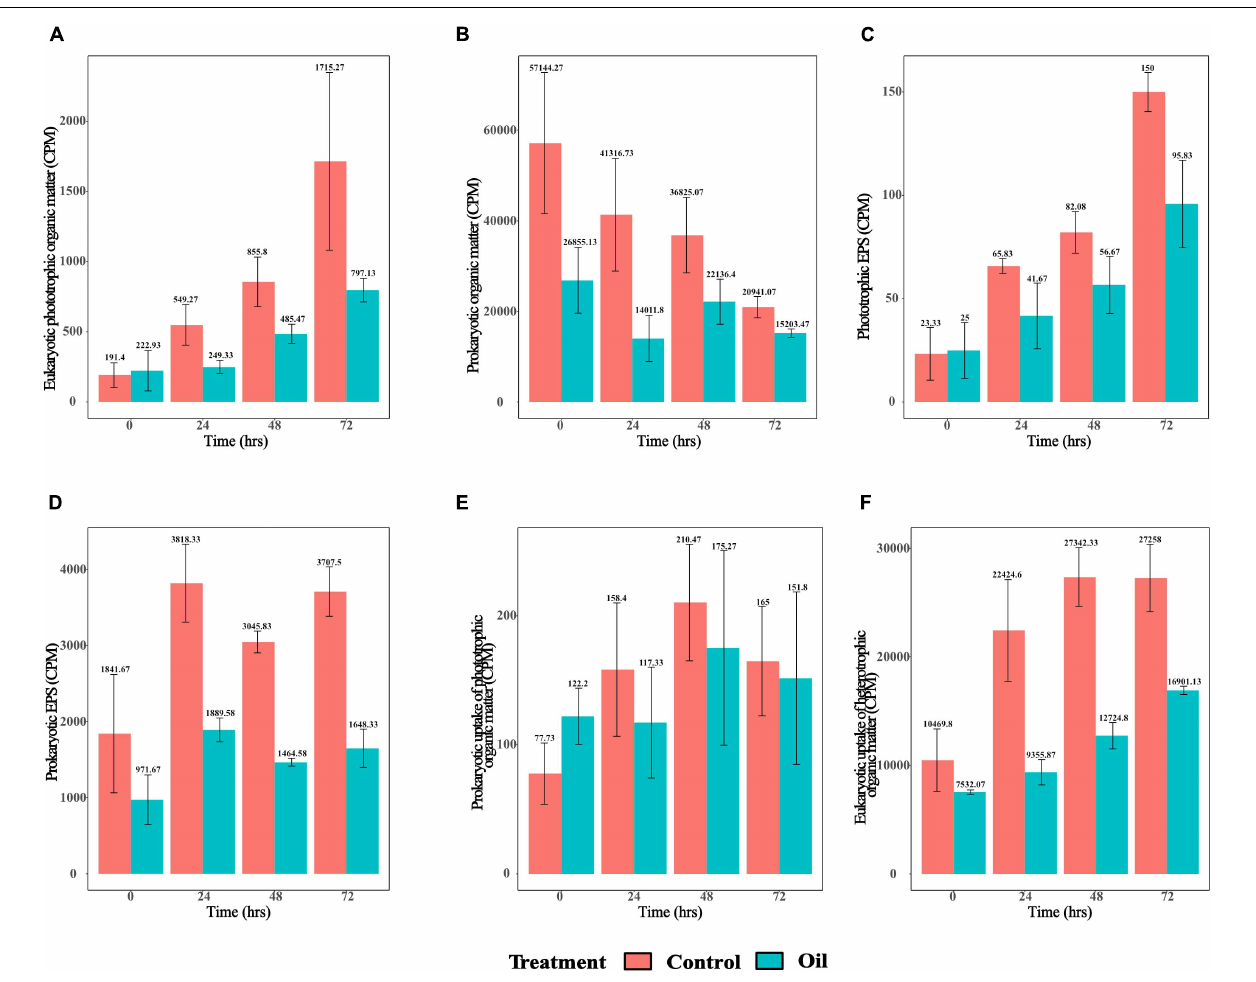
FIGURE 1 | Radiotracer signals from the long-term experiment. (A) Eukaryotic phototrophic organic matter as indicated by the 14 C signatures in ≥ 3- µ m fraction (CPM), (B) prokaryotic organic matter as indicated by 3 H signatures in ≥ 0.2- µ m fraction (CPM), (C) phototrophic exopolymeric substance (EPS) as indicated by 14 C signatures in ≥ 3-kDa fraction (CPM), (D) heterotrophic EPS indicated by 3 H signatures in ≥ 3-kDa fraction (CPM), (E) prokaryotic uptake of phototrophic organic matter as indicated by 14 C signatures in ≥ 0.2- µ m fraction (CPM), and (F) eukaryotic uptake of heterotrophic organic matter as indicated by 3 H signatures in ≥ 3- µ m fraction